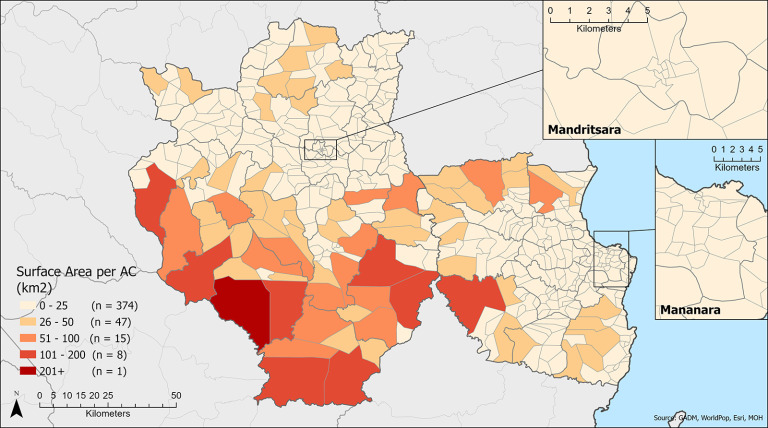
Surface Area to ACs in MadagascarAbbreviation: ACs, agents communautaires (community health workers).